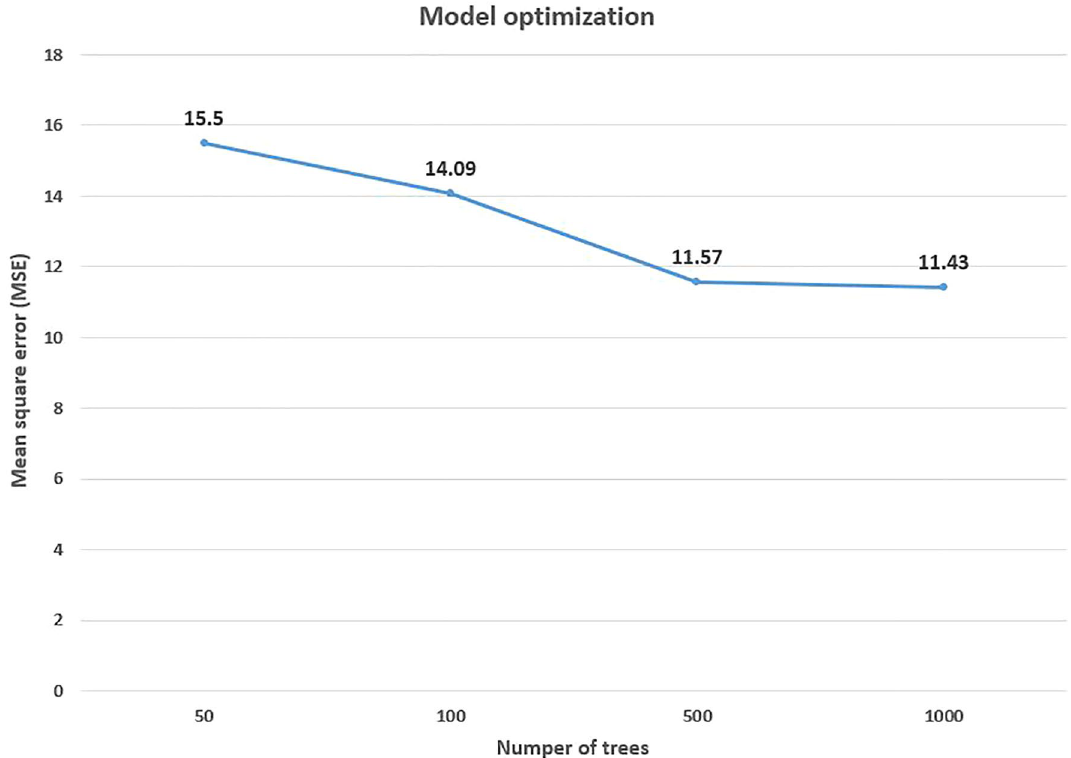
Fig. 7 Number of trees as a hyper-parameter